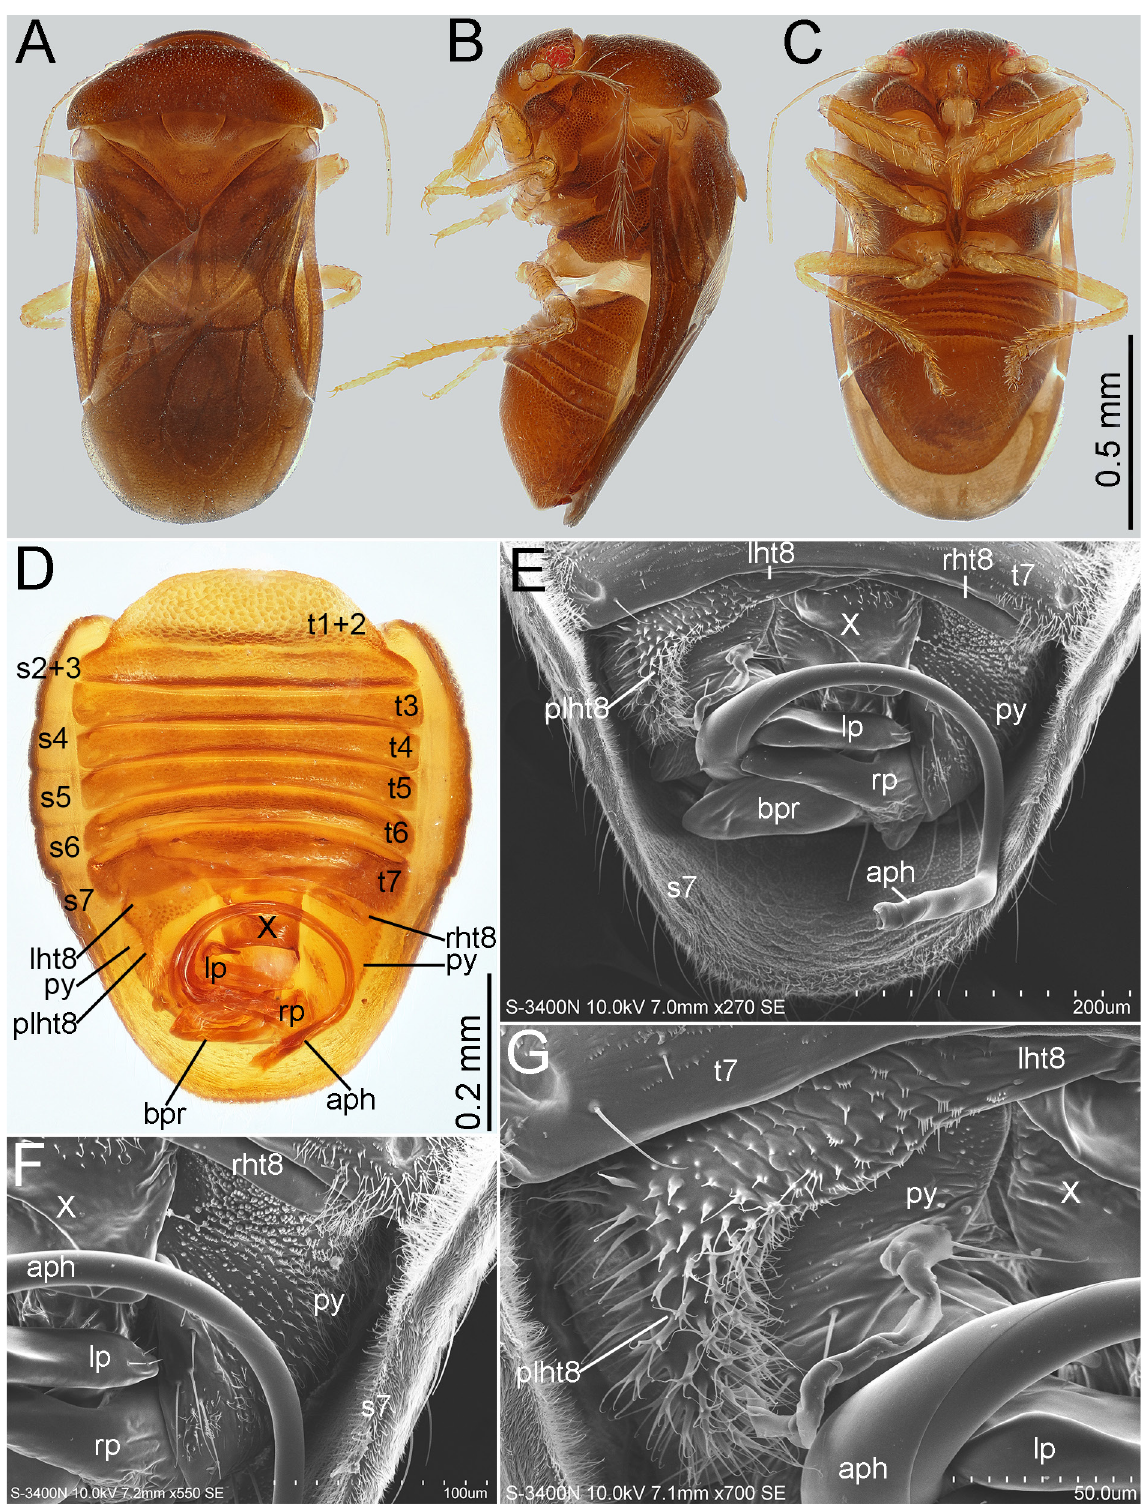
Fig. 7. Kokeshia caii sp. nov. A‒C . Habitus, holotype, ♂ (SYSBM). A . Dorsal view. B . Lateral view. C . Ventral view. D . Pregenital abdomen and genitalia, dorsal view, paratype, ♂ (SYSBM). E‒G . Scanning electron micrographs of genitalia, paratype, ♂ (SYSBM). E . Dorsal view. F . Right side, dorsal view. G . Left side, dorsal view. Abbreviations: see Material and